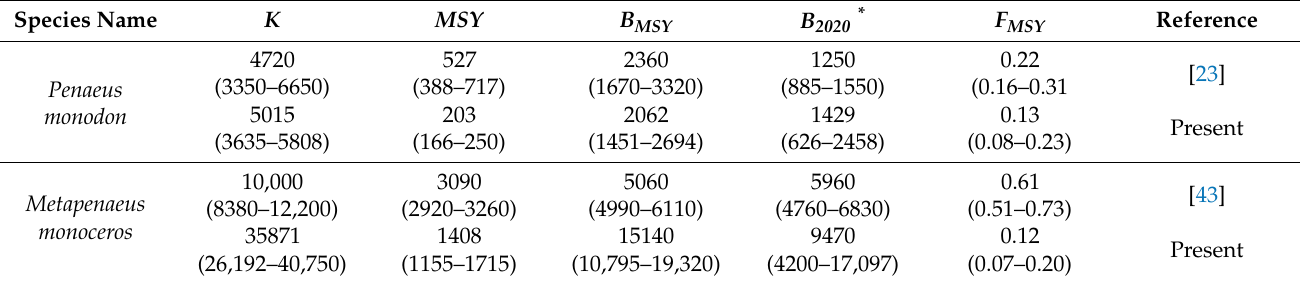
Table 3. The mean of the estimated reference points for Penaeus monodon and Metapenaeus monoceros by Barua et al. (2020 and 2021) [23,43] and the present study with 95% confidence